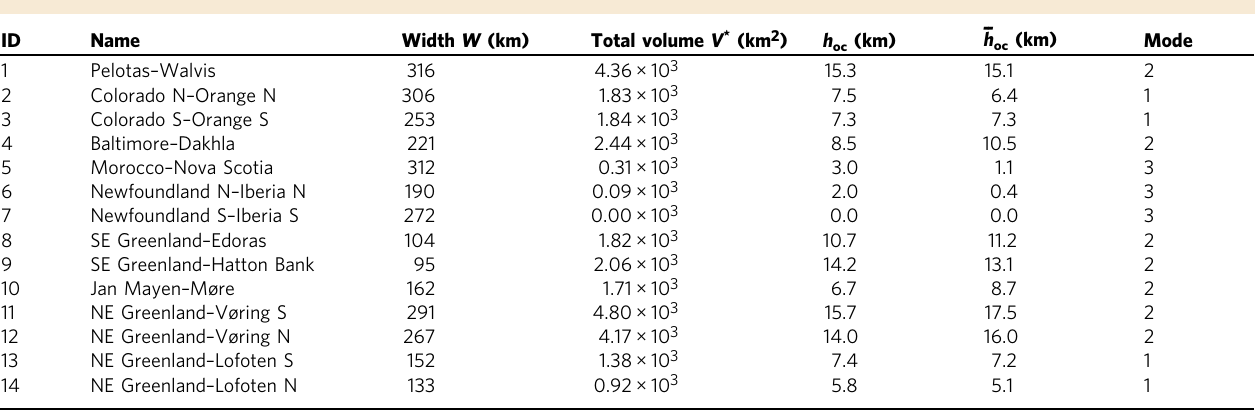
Fig. 4 Melt volume – margin width correlation. Model results at mantle potential temperatures of 1280 °C (blue diamonds), 1300 °C (green triangles), 1330 °C (inverted pink triangles) and 1380 °C (magenta stars) all show quasi-linear correlation between margin width and melt volume, respectively. Dashed lines show semi-analytical prediction of melt volume versus width with parameterized oceanic crustal thickness h oc = 4 km (blue), 6 km (green), 8 km (pink) and 14 km (magenta). Table 1 Magmatic mode classi fi cation of North, Central and South Atlantic